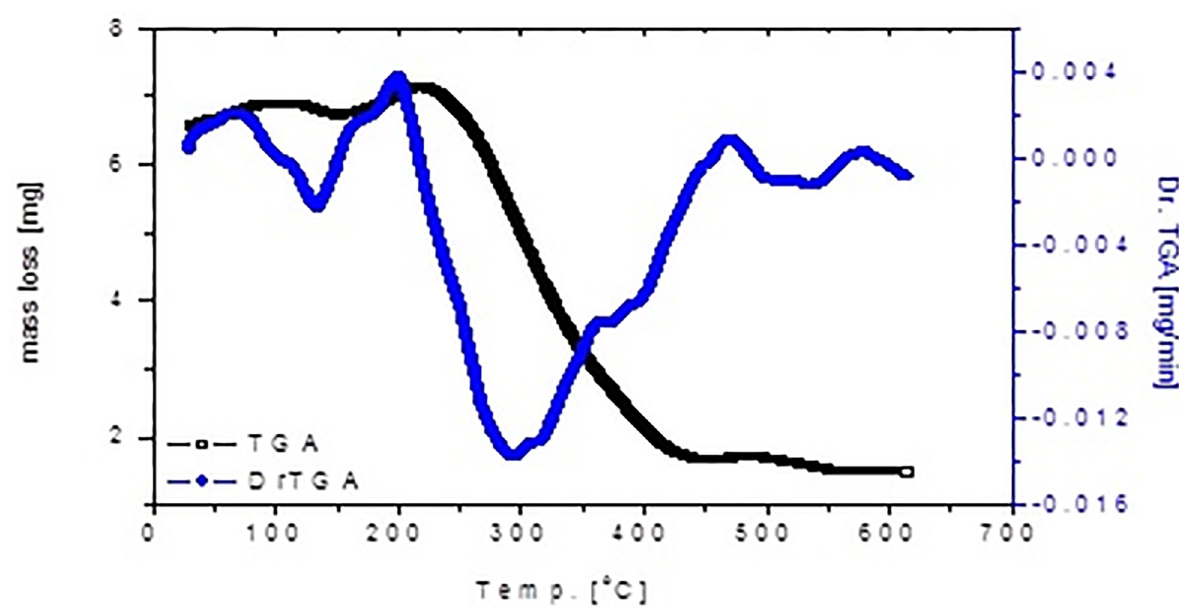
Fig 6. TGA-DrTGA curves of